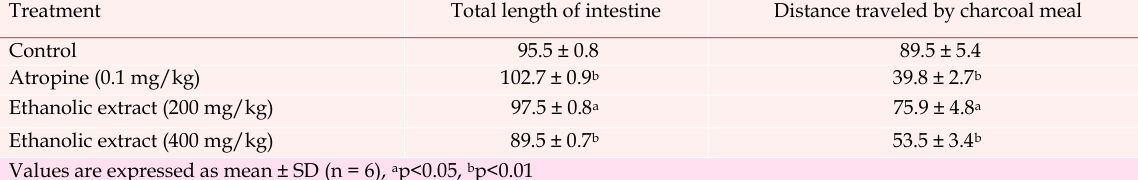
Evaluation of anti-diarrheal activity of ethanolic extract of D. malabarica by charcoal-induced gut transit time Treatment